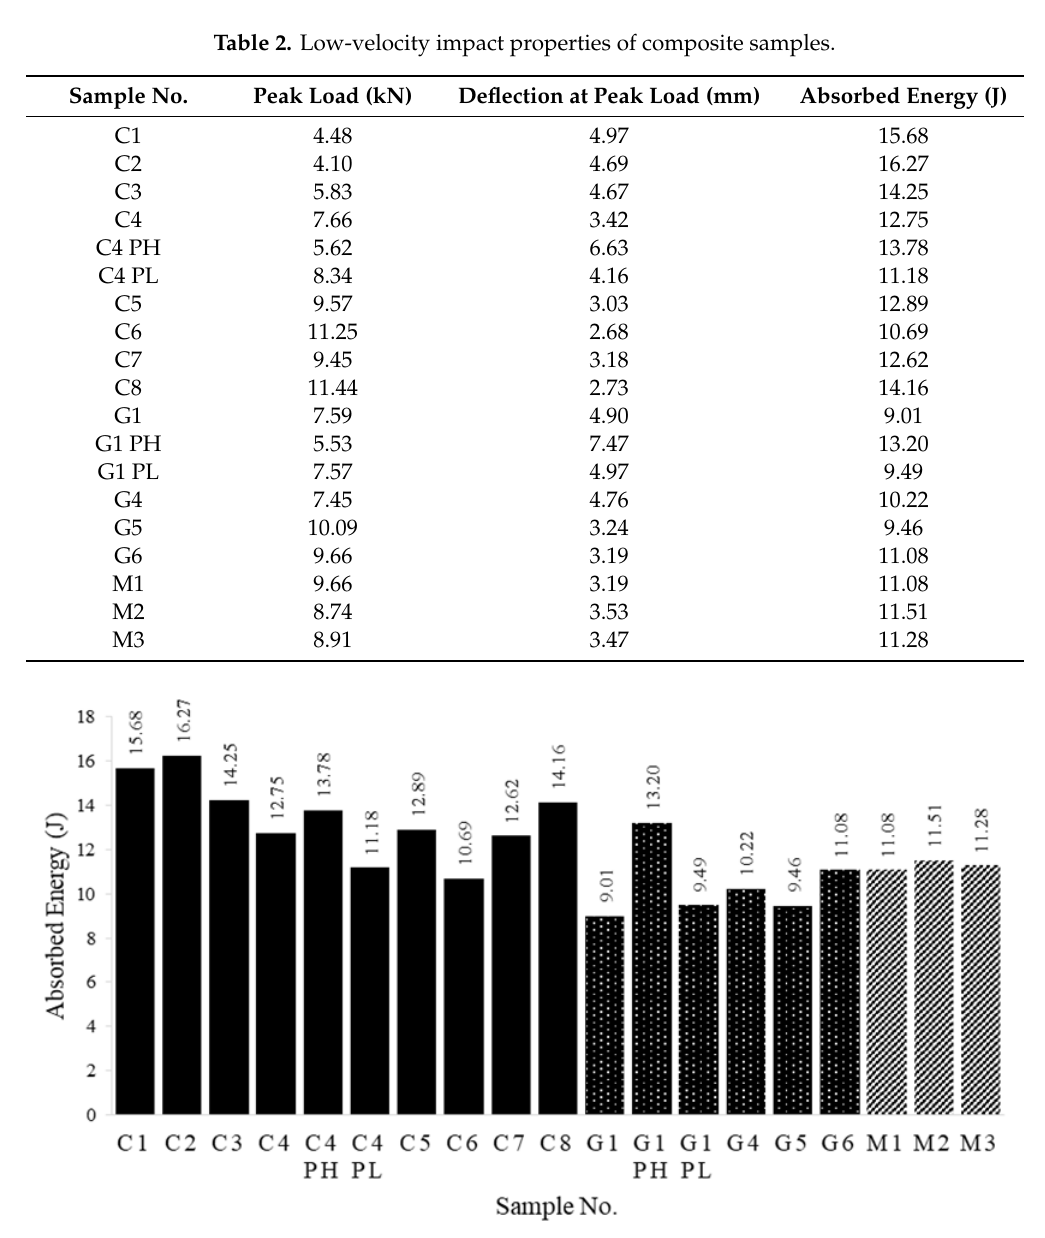
Figure 5. Summary of the measured peak loads for all composite plates . 3.2. Carbon Fiber-Reinforced Polymer (CFRP) Plates Table 3 and Figure 6 summarize the measured absorbed energies for the tested carbon-fiber plates. The tests show that the impact resistance was affected by the thickness of the plate and the number of plies. It is clear that carbon-fiber composite samples C1, C2, and C3 exhibit the highest absorbed energy. Carbon-fiber plate C2 has the highest measured absorbed energy, then C1, C3, C4 PH, C4, C5, C4 PL, and C7, while C6 has the lowest absorbed energy. The maximum impact force is found to be approximately 11.45 KN for carbon-fiber composite sample C8, while the minimum impact force was measured for carbon-fiber sample C2. The higher impact force is attributed to the energy release due to the composite damage (delamination and matrix cracking). It worth mentioning that there are almost negligible differences in the measured absorbed energies for C5, C4 PL, and C7. In general, a further increase in the overall thickness of the carbon-fiber plate, either through an increase in layer thickness or by increasing the number of layers, resulting in a decrease in performance. Physically, when the thickness of the composite plate is small, the plate behaves more like a membrane and stretches during impact until all the kinetic energy is transferred to the plate. Then, it pushes back the impactor giving some of the energy back to the impactor, where the rest is dissipated in the form of damage within the plate. The more the thickness of the plate is increased, the stiffer it becomes, and the ability to bend under impact loads is reduced, which increases the bending stress, and hence, the plate suffers more damage. At very high thickness, the plate becomes very strong, which results in deficient amounts of energy absorbed.